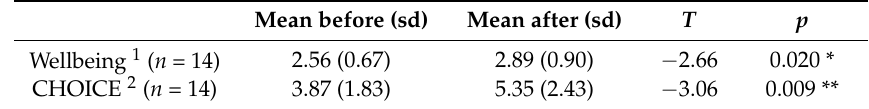
Table 2. Changes in wellbeing from before to after course attendance.